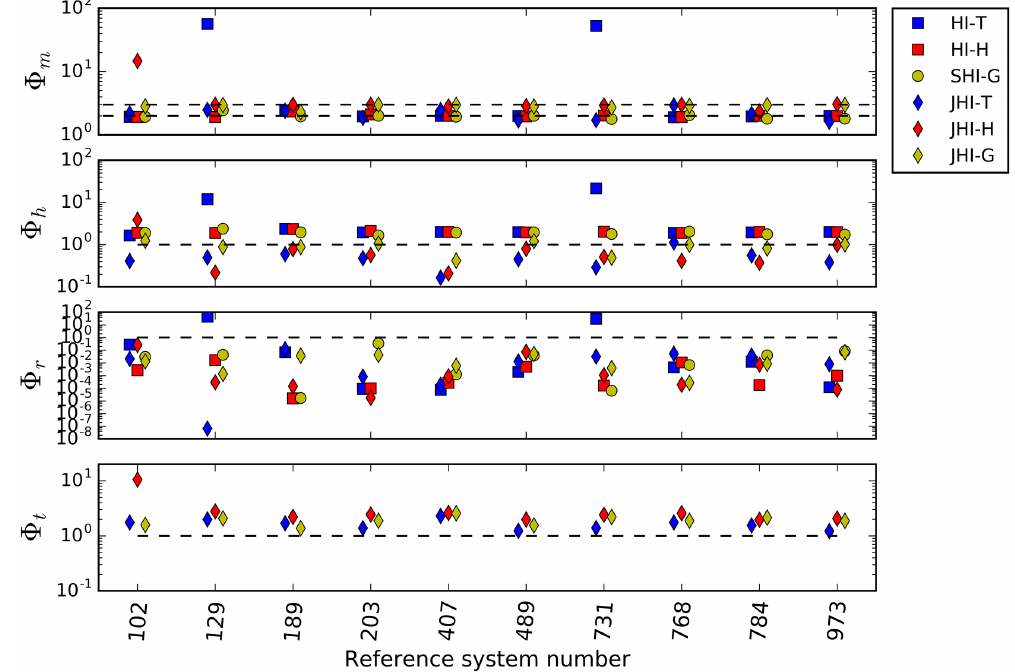
Figure 4. Measurement objective function value obtained for the various groundwater model calibration cases and for the 10 different system realizations. The two dashed lines in the top plot indicate the target value for the various model calibrations: the upper dashed line is the target value for the JHI, and the lower dashed line is the target value for HI and SHI. The dashed line in the three lower plots similarly marks the respective target